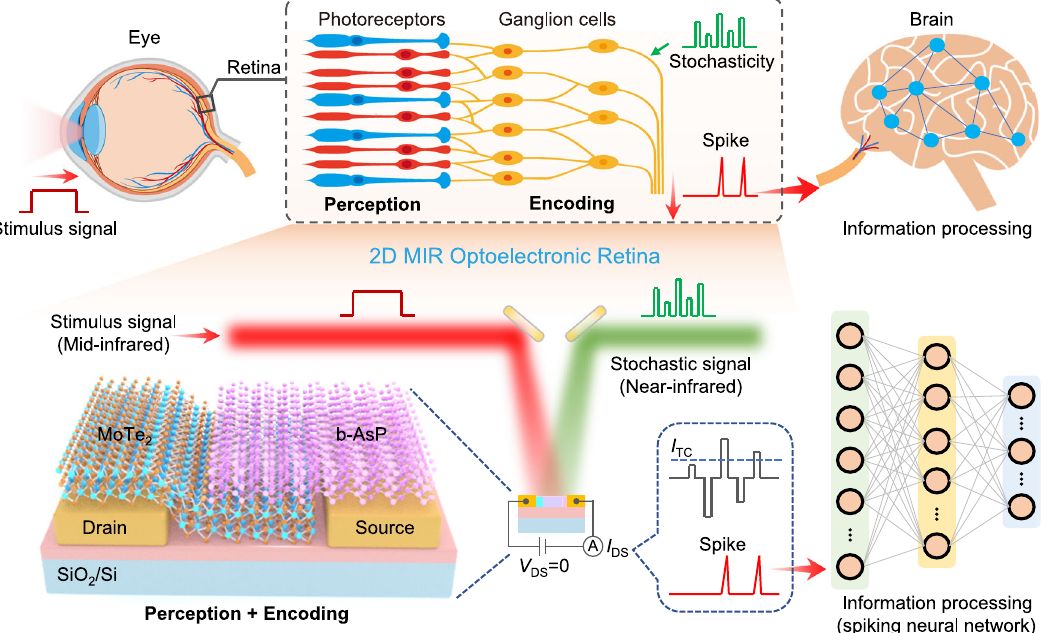
Fig. 1 | Schematic of human visual system and the proposed 2D MIR optoe- lectronic retina. In the human visual system, the stimulus signal from external object entering the eye is fi rst converted into corresponding graded potentials by the photoreceptors (rod and cone cells) in the retina. The potentials are then encoded into spikes by ganglion cells with the participation of inherent stochas- ticity (random signal) exhibited in sensory transduction. Finally, the spikes with coded stimulusinformation are transferredto the visual cortexinbrainforfurther